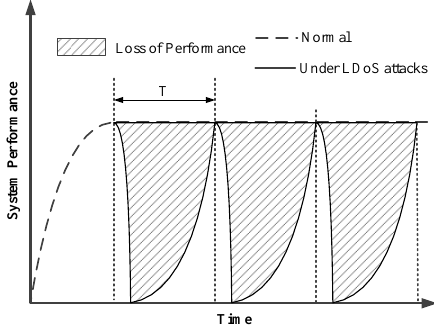
Figure 3. The impact of LDoS attacks on system